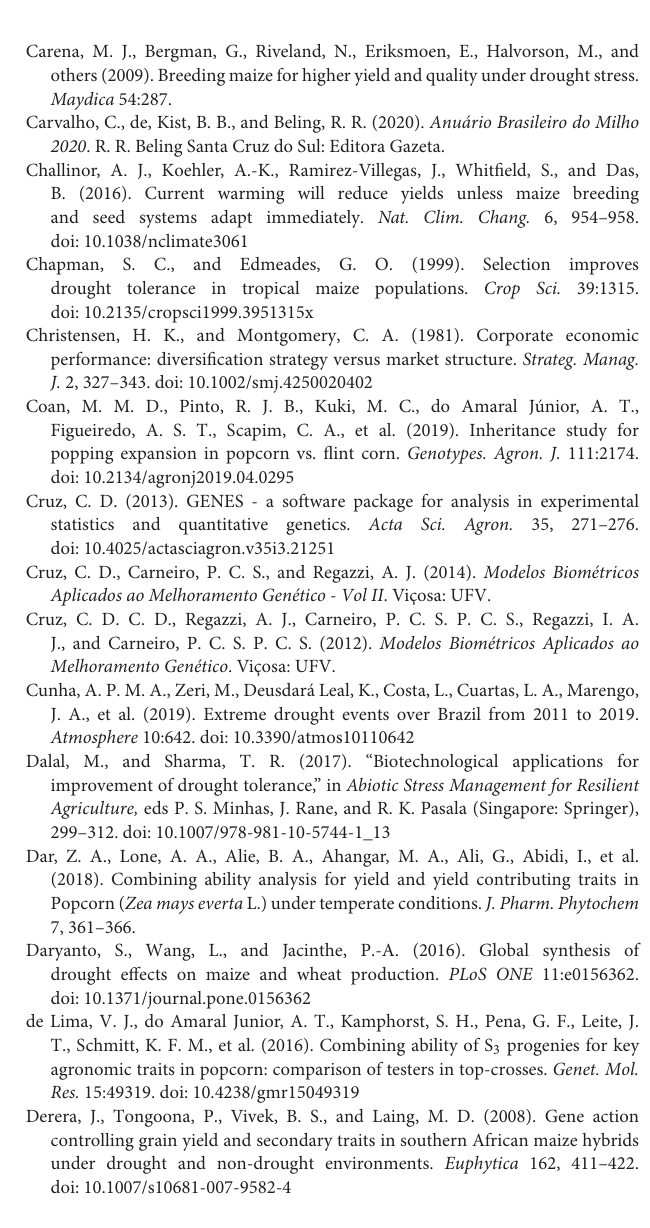
Supplementary Figure 1 | Soil water potential (MPa) in days after sowing (DAS) for experiments performed during the 2018 and 2020 harvests with popcorn inbred lines in water-stressed (WS in red) and well-watered (WW in blue) conditions. Supplementary Figure 2 | Weekly average values on DAS of temperature ( ◦ C), relative humidity (%), and solar radiation ( µ mol m − 2 s − 1 ) throughout the growing period of the experiments with popcorn inbred lines during the 2018 and 2020 crop